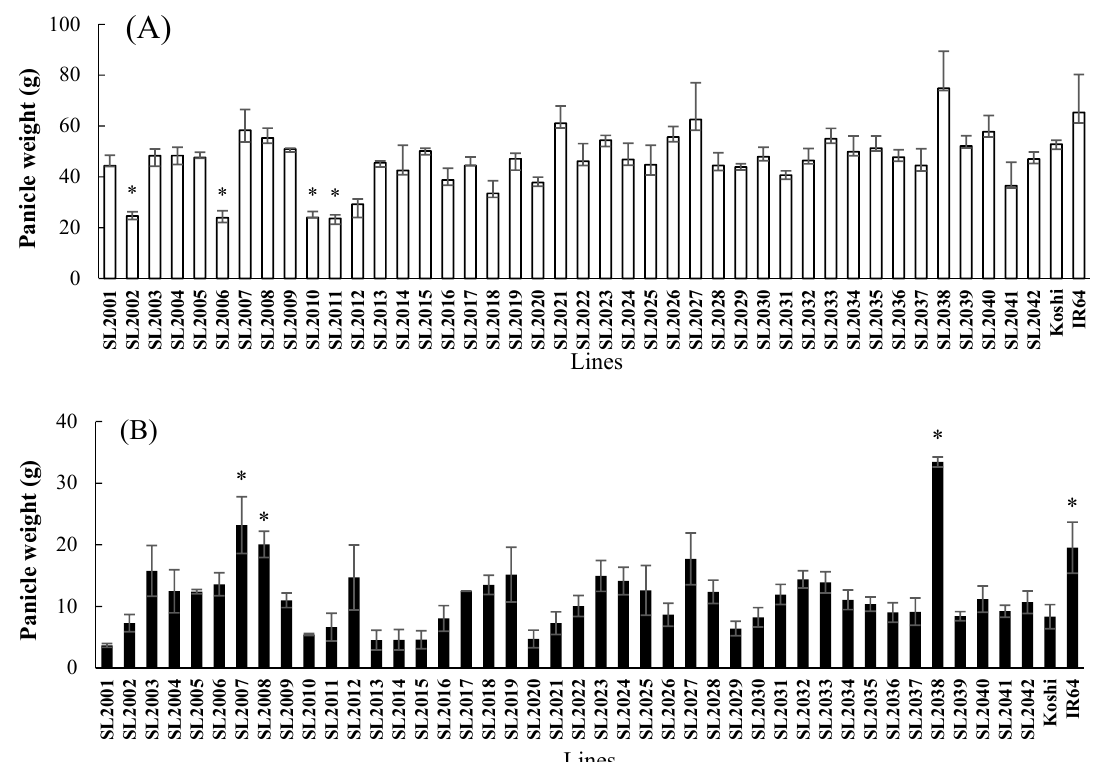
Figure 2. Plant dry weight values of 42 chromosome segment substitution lines (CSSLs) and parents under ( A ) non-stress and ( B ) salt stress conditions in 2014. Values are mean ± standard error (n = 3). * indicates a significant difference between Koshihikari and CSSL at the 5% level by Dunnett’s test.